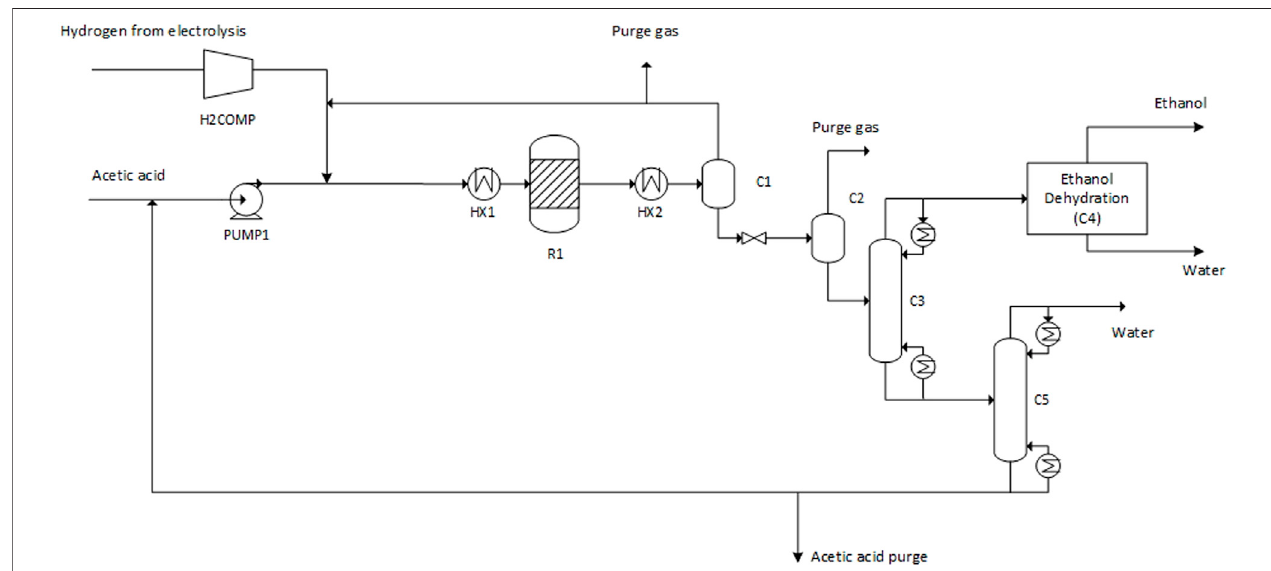
FIGURE 5 | Flowsheet of the acetic acid hydrogenation to ethanol process.